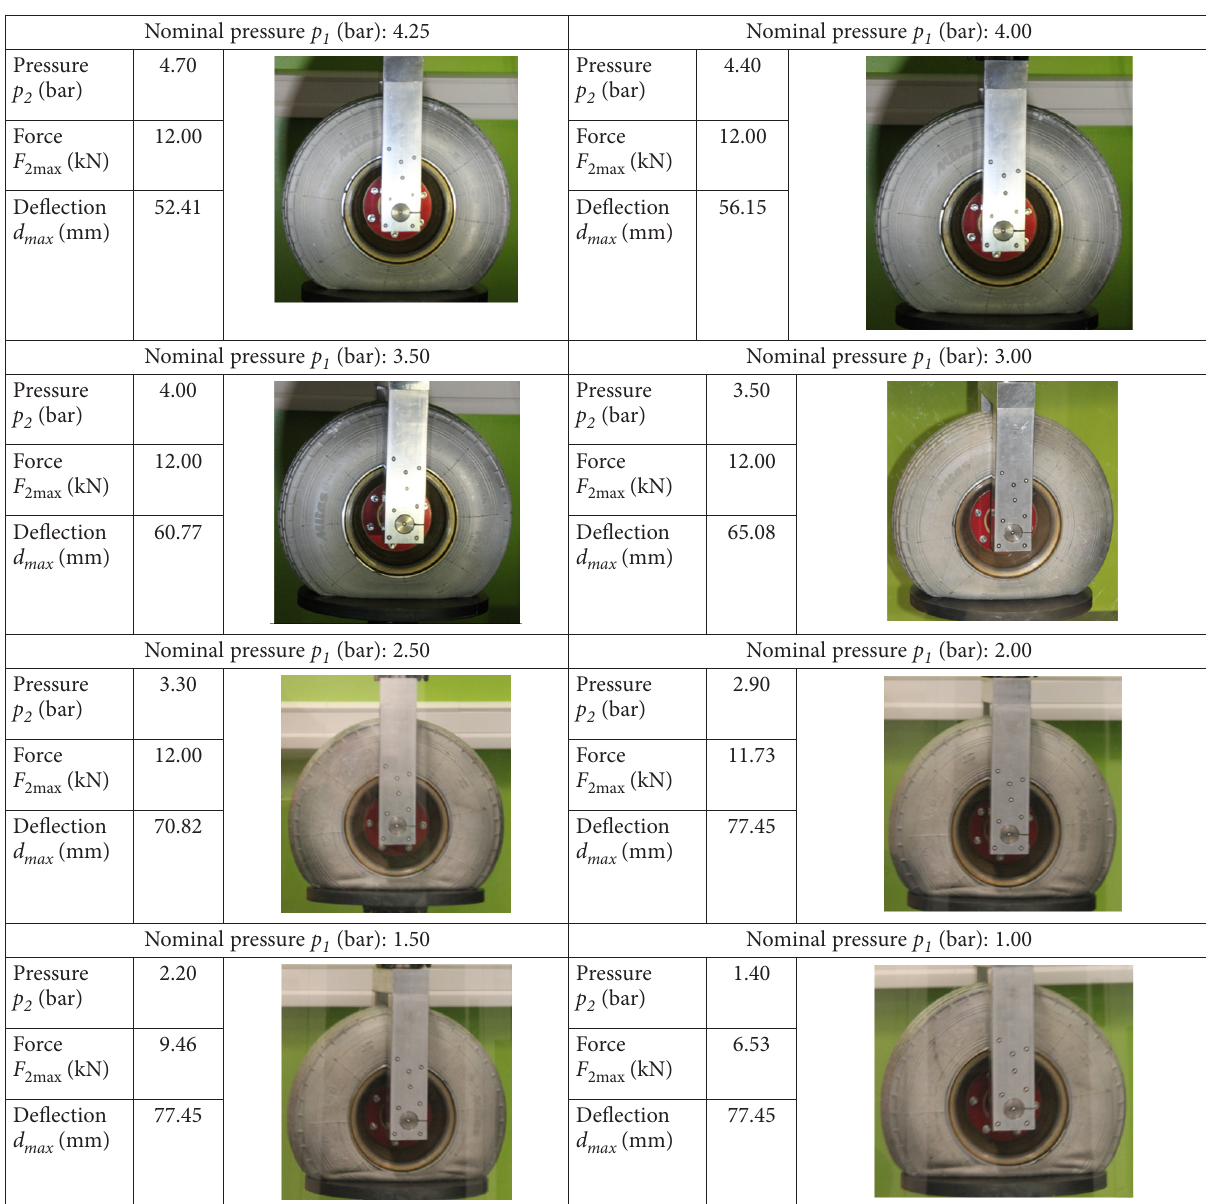
Table 1. Airplane tyre load test